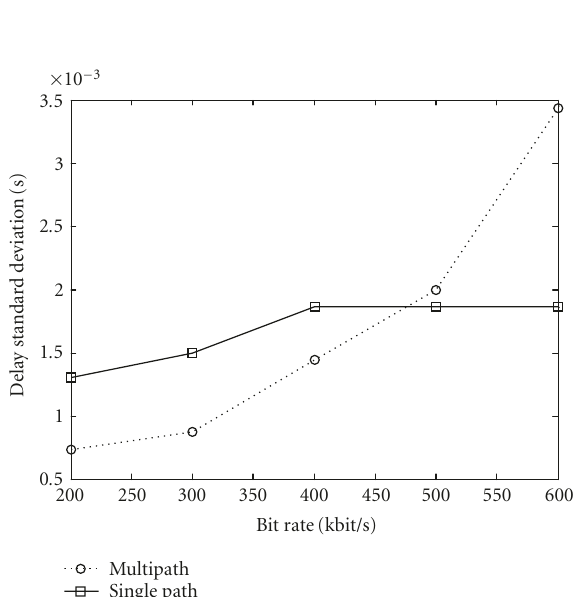
Figure 8: End-to-end average delay.